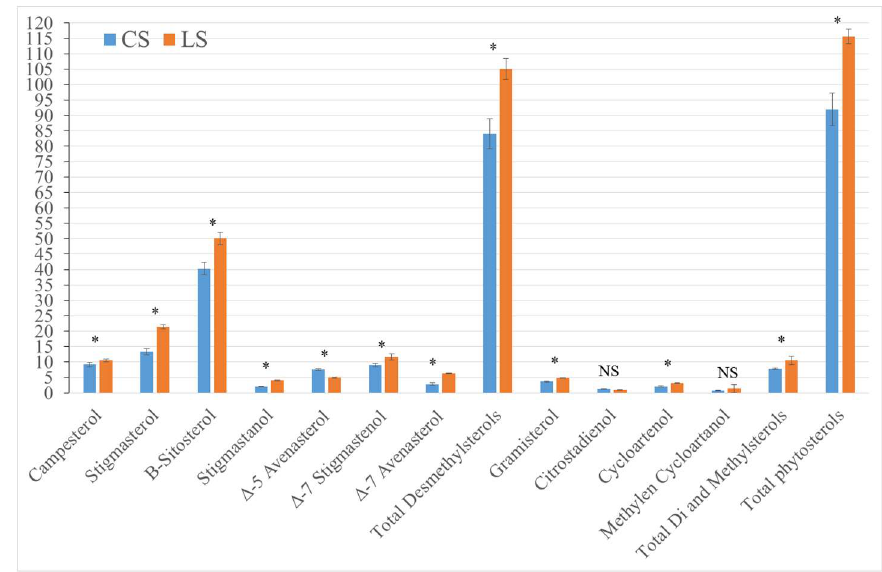
Figure 4. Phytosterol composition of safflower seeds cultivated under conventional and late sowing dates in Auch (South-West of France) in 2007. The asterisk indicates that means are significantly different. NS: Non-significant.